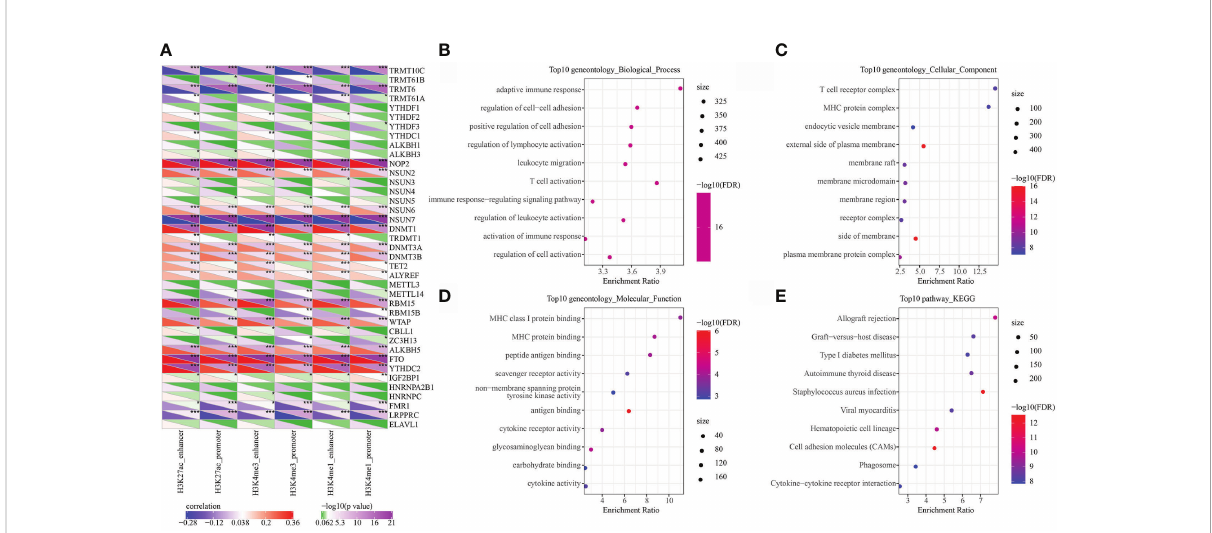
FIGURE 4 Epi-PCGs and RNA modi fi cation correlation and functional enrichment analysis. (A) Correlation between the enrichment scores of 6 kinds of epigenetic modi fi cation; (B) Epi-PCGs-enriched BP annotation map; (C) Epi-PCGs-enriched CC annotation map; (D) Epi-PCGs-enriched MF annotation map; (E) Epi-PCGs-enriched KEGG annotation map. The abscissa represents the enrichment score, and the ordinate represents the enriched functions or pathways. The size represents the number of gene enrichment, and the color represents P-value. *P < 0.05, **P < 0.01, ***P < 0.001.